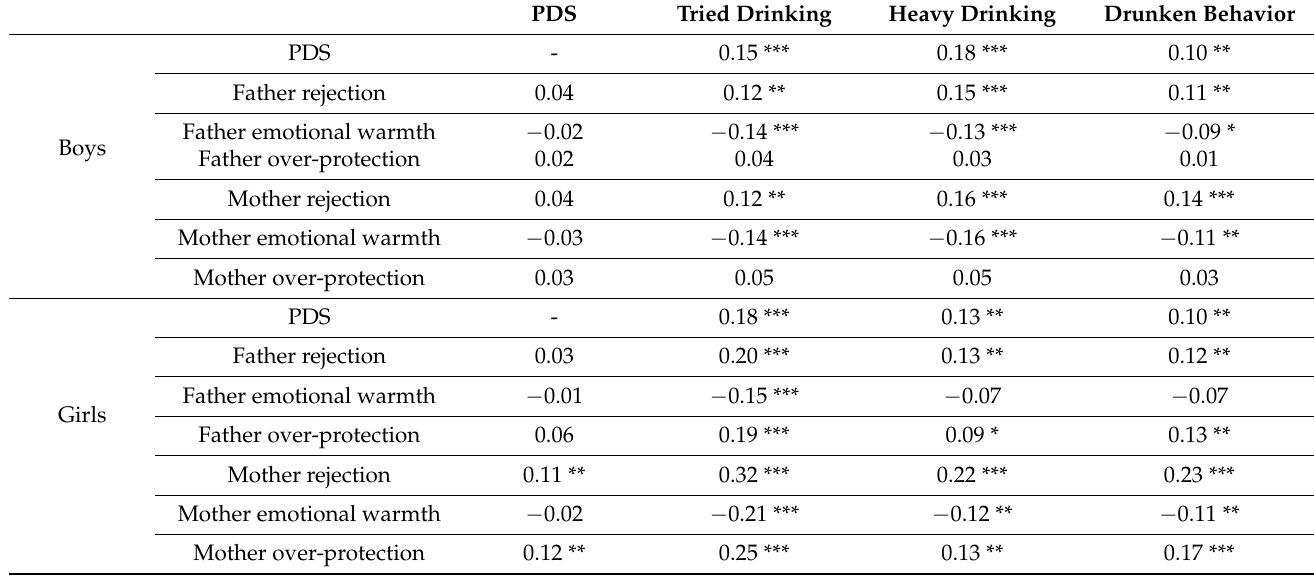
Table 3. Correlations among primary study variables.